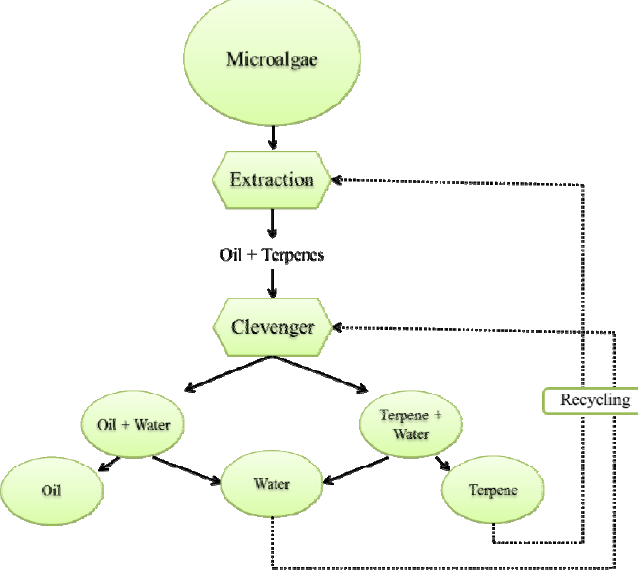
Figure 1. Extraction procedure using terpene